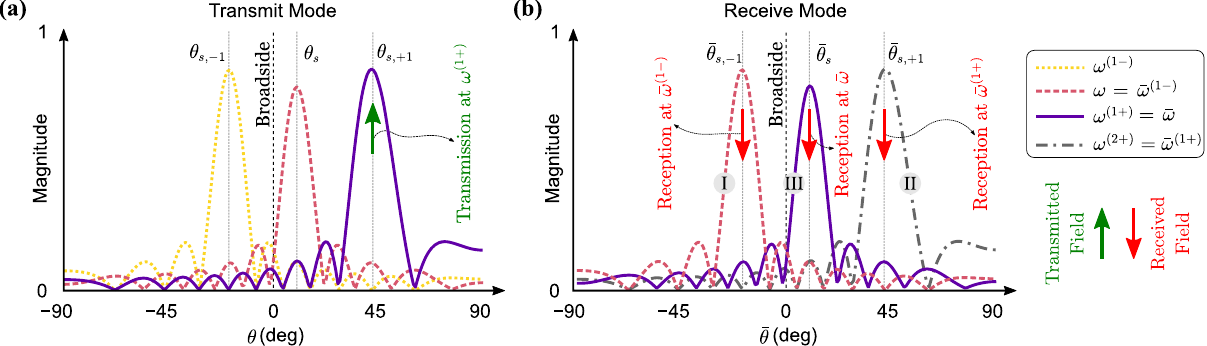
Figure 5. ( a ) Transmission pattern of the STP array in TX mode. The up-converted transmission channel is represented with the rightmost curve and the green arrow. ( b ) Listening pattern of the STP array in RX ω ω ( 1 + ) . Down-converted, up-converted, and fundamental mode for an incident wave with a frequency of ¯ = listening channels are denoted by the red arrows and are marked (I) through (III). These will be detected if the incident direction is ¯ θ s , 1 , ¯ θ s , 1 , or ¯ θ s , respectively. Upon comparing the three listening patterns (I–III) with − + the transmission pattern marked with the green arrow in ( a ), different types of nonreciprocity (momentum, frequency, and double) are shown to have materialized. Parameters used are as follows: δ 2.9154 π rad/m, and ω m /ω 0.01 rad/m, κ m = =